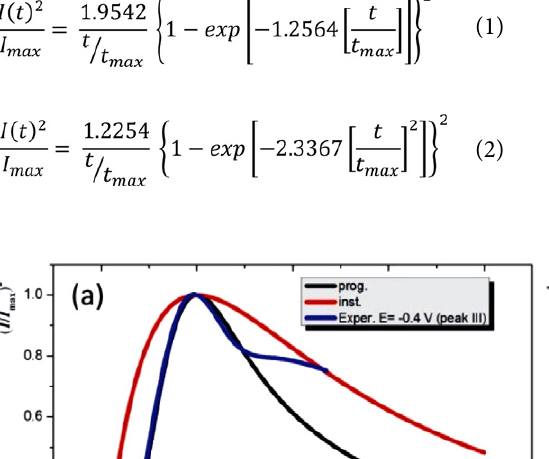
Fig. 7 (a-e) shows the nondimensional I 2 /I 2 max vs. t/ t max plots derived from the CA data at different conditions as in Fig. 6. The solid lines of black and red color are the theoretical transients of the instantaneous and the pro- gressive nucleation, and blue lines for the experimental data. The nucleation and growth processes of iron at these conditions can be derived from Fig. 7 (a–e). At the early stage, the experimental curve fits well with the curve of the progressive nucleation model by which the iron nucleation occurred on many active sites of Pt substrates. Subse-